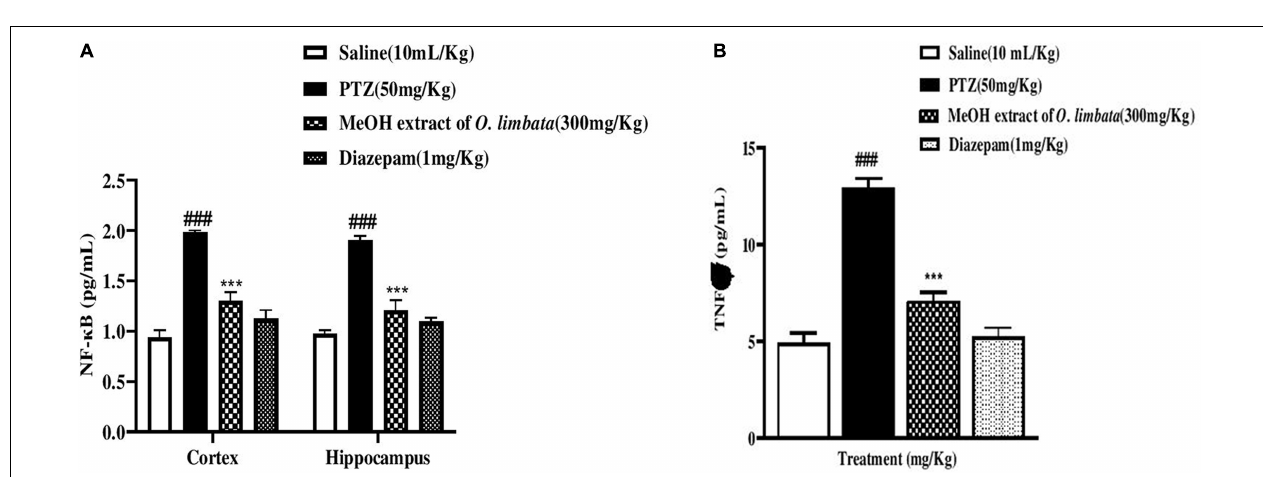
FIGURE 7 | (A) Slides demonstrate the morphological comparison of PTZ and treated group of mice using hematoxylin and eosin (H&E) staining. The difference in number of surviving neurons is clear in graphs. (B) Symbols ### indicate significant difference from saline at P < 0.001 while symbols ** indicate significant difference from PTZ (disease) group at P < 0.01.